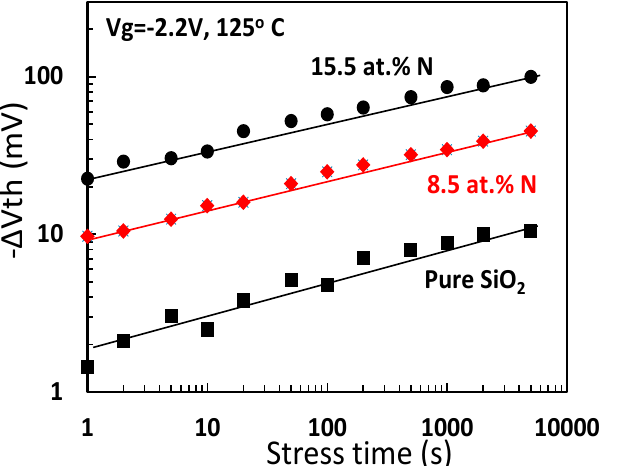
Figure 4. Increase of nitrogen density in SiON raises NBTI. The NBTI follows a power law [14]. On the physical process, the Si–H bond at the interface is generally believed to be the precursor for generated interface states [17]. During NBTI stress, Si–H is ruptured, and the released hydrogenous species then migrate into the gate oxide, leaving behind the Si